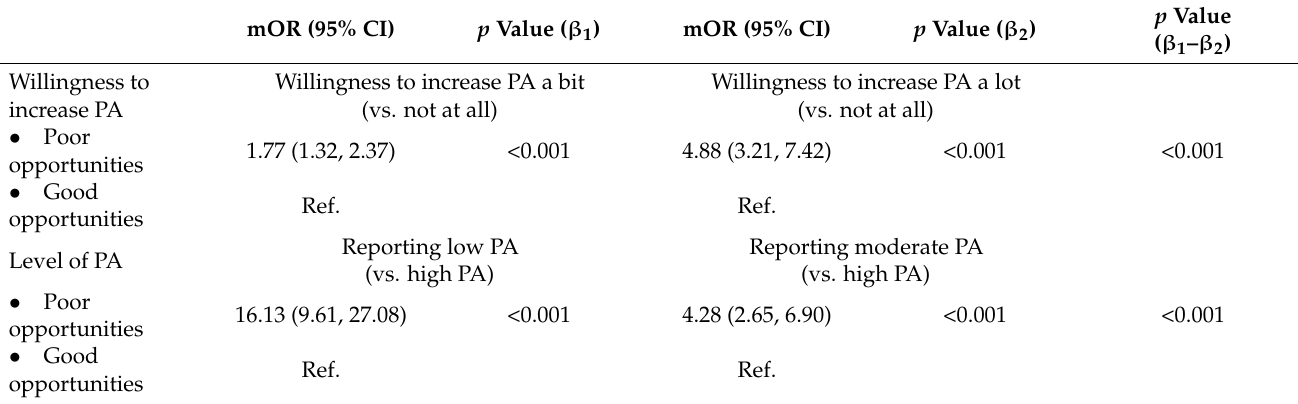
Table 3. Association between opportunities and willingness to increase physical activity (PA) and level of reported physical activity. Results of the joint main effects model for willingness to increase physical activity and level of physical activity predicted by poor vs. good opportunity ( n =